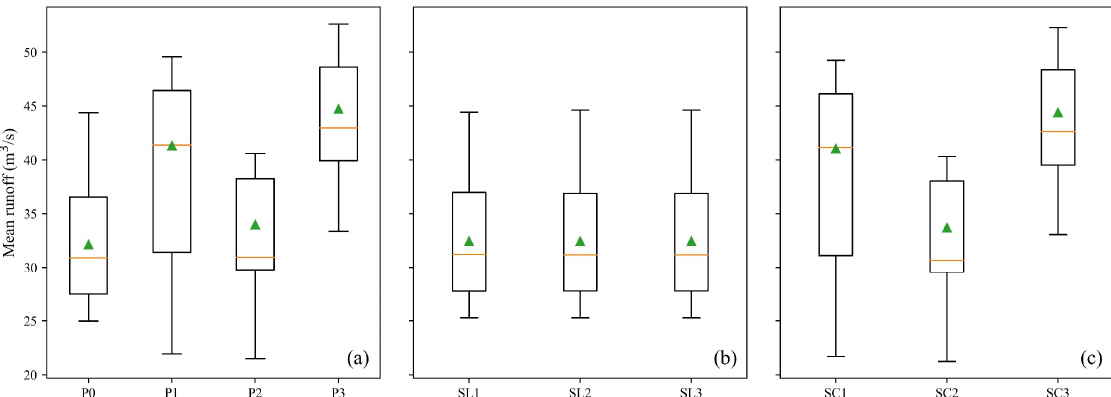
Figure 7. Simulated surface runoff under three different scenarios, ( a ) actual simulation, ( b ) land use change simulation and ( c ) climate change simulation. The green triangles represent the mean values, and the orange horizontal lines represent the medians.